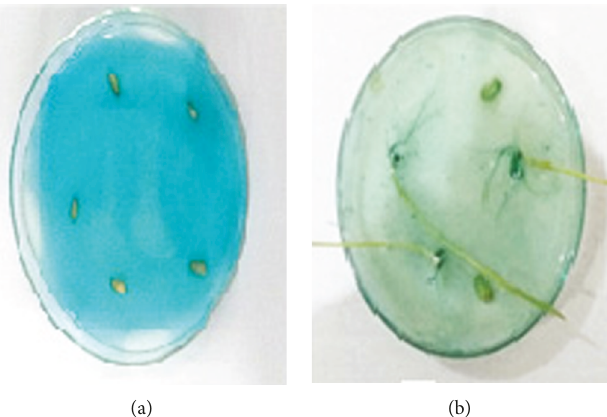
Figure 7: (a) Germination of seeds in the original MB solution. (b) Germination of seeds in the treated MB solution. Table 1: Name of the kinetic models used, mathematical form of the kinetic models, regression coe ffi cient ( R 2 ), and rate constant ( k ) for reduction of MB with CPUF, ascorbic acid, and mixtures of ascorbic acid and Psidium guajava or Citrus limon extracts at temperature 33 ° C ± 3 . Sr. no.